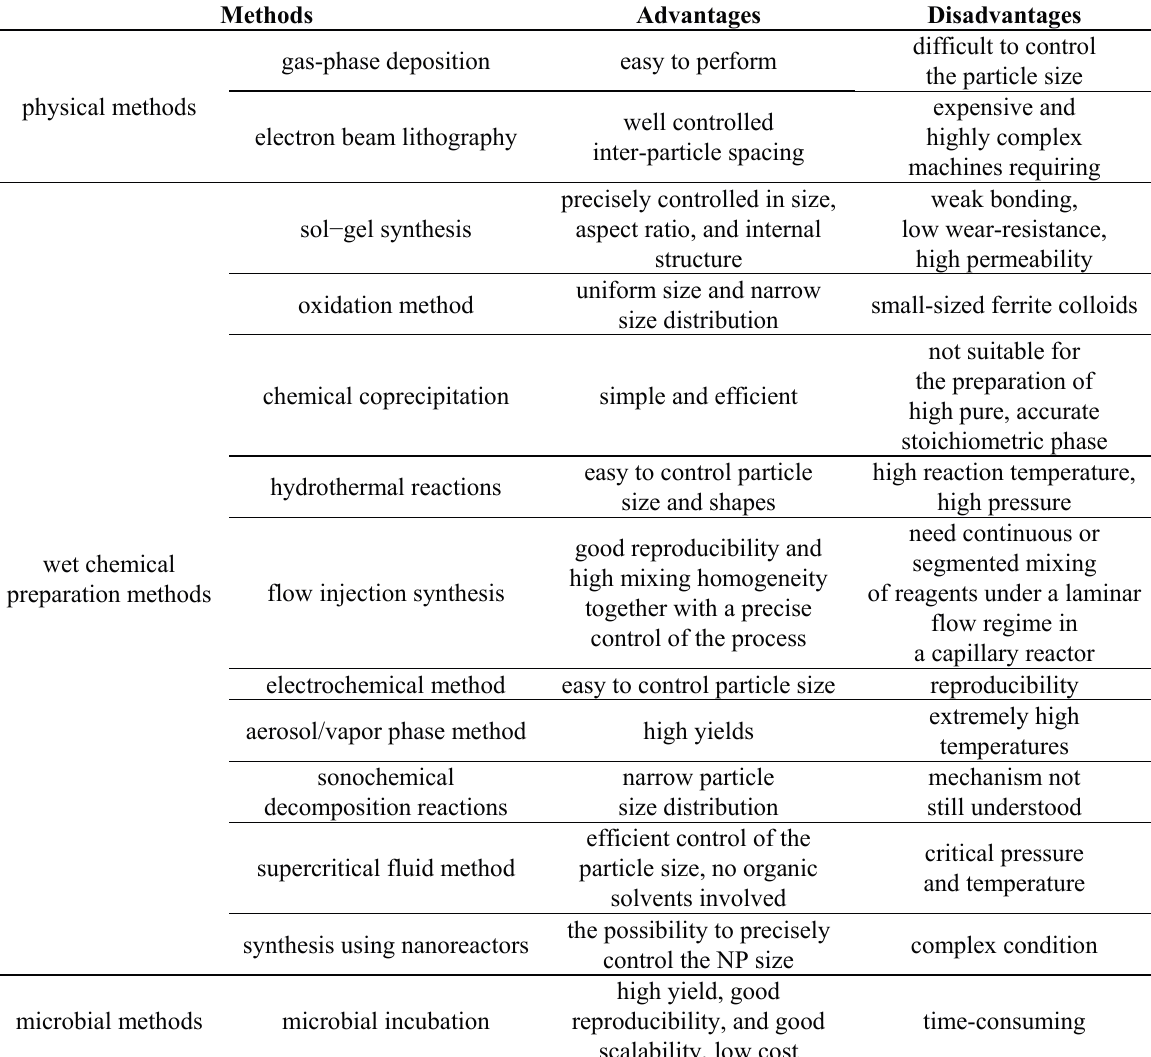
Table 1. Comparation between methods for synthesis of magnetic